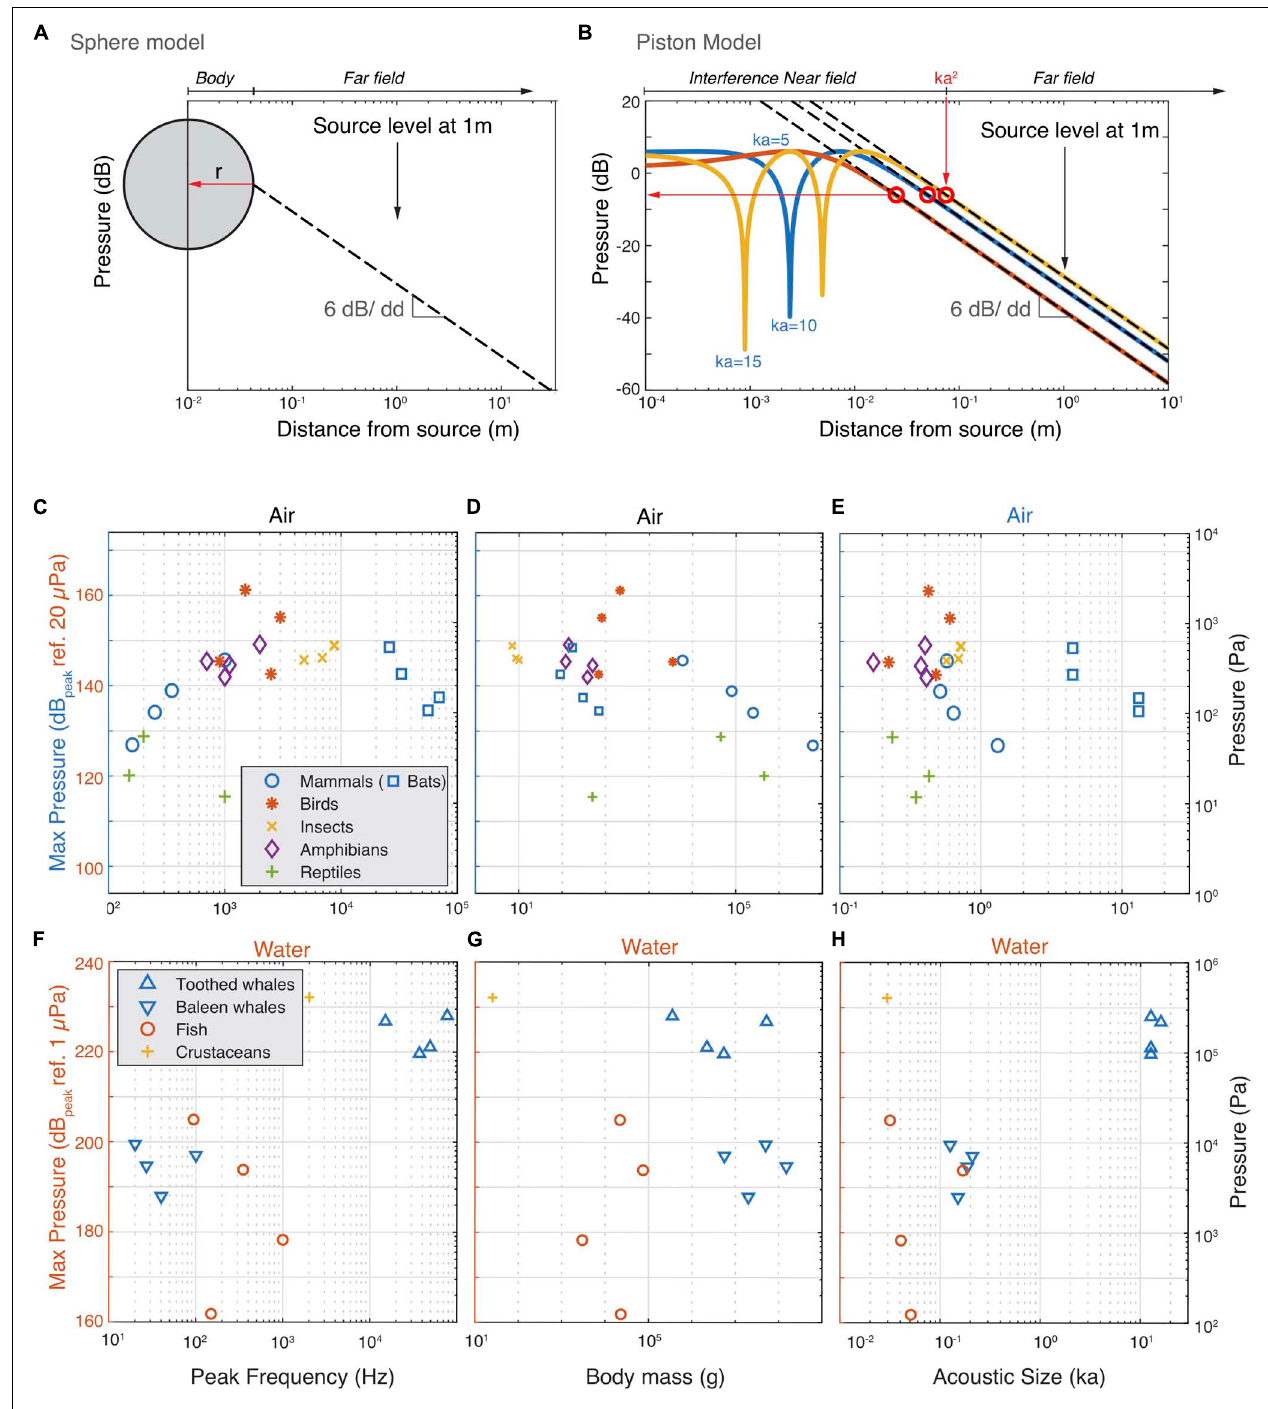
FIGURE 4 | The estimated highest occurring sound pressures in air and water. (A) For animals that are omni-directional sound radiators we used the monopole model to estimate the highest occurring pressure (red horizontal arrow). Because a monopole does not have a near field, we assumed the radius of the monopole to be the body wall (see section “Materials and Methods”). In far field conditions, the sound pressure decreases with 6 dB per doubling of distance. (B) For highly directional sound radiators (bats and cetaceans), we used the piston model to estimate the highest occurring pressure. We use the conservative estimate that the highest occurring pressure (red horizontal arrow) occurs at the border of the interference near field and far field (see section “Materials and Methods”). (C–E) Estimated highest produced sound pressures increase with frequency but plateau at about 150 dB ref. 20 µ Pa by animals vocalizing in air. (F–H) Estimated highest produced sound pressures seem to increase with frequency and size for animals vocalizing in